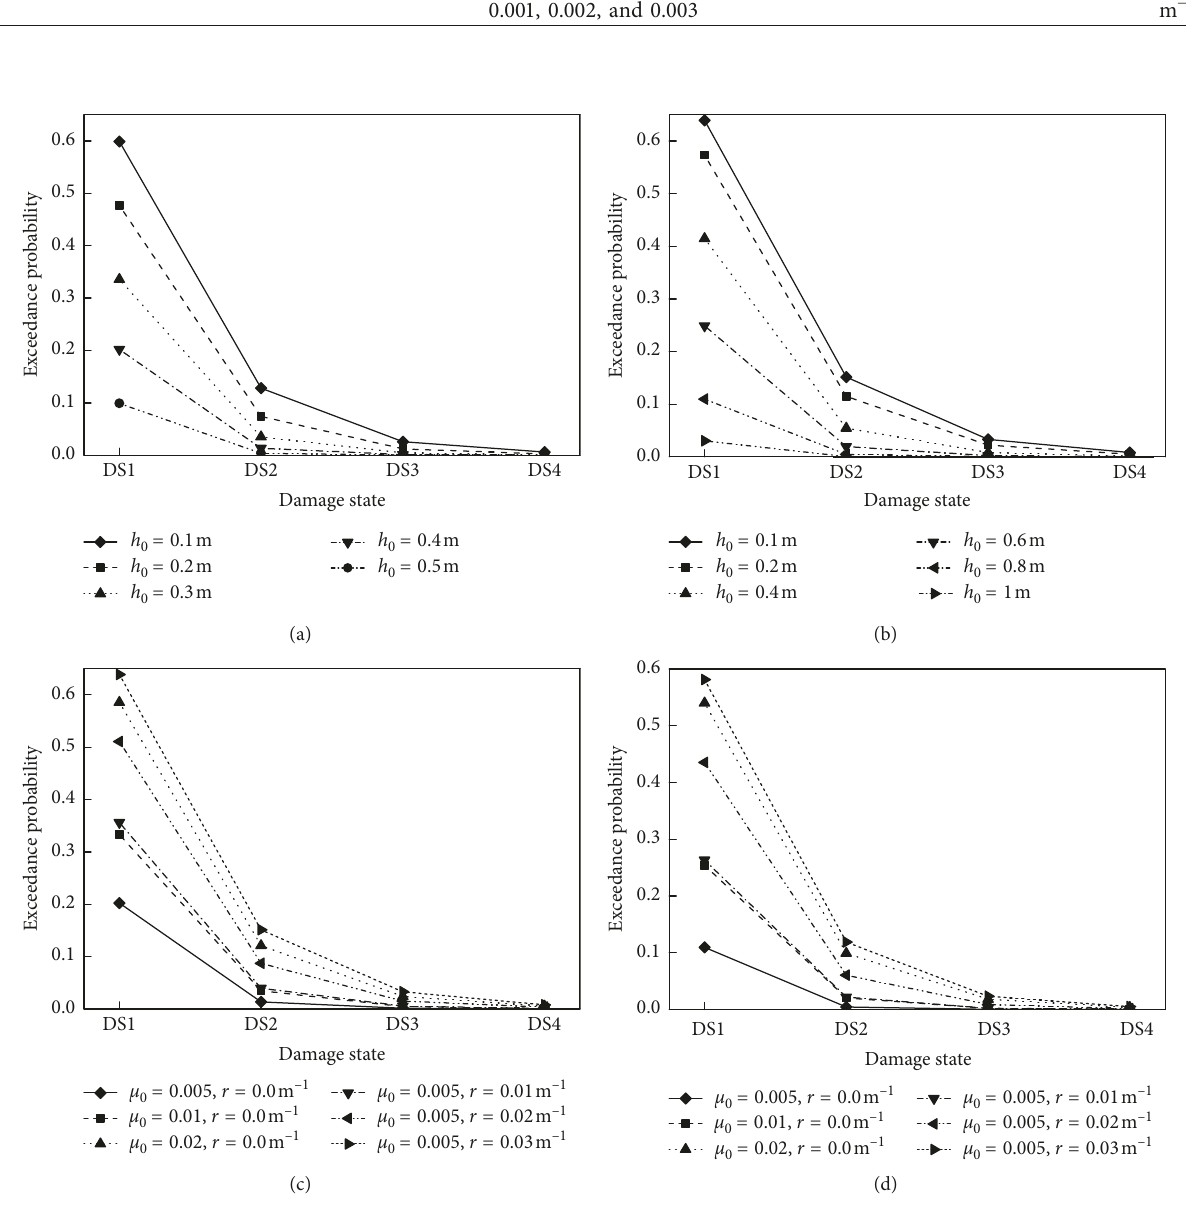
Figure 4: Structural peak acceleration when K are defined by the structural peak acceleration in Table 2). (a) μ 0 (c)